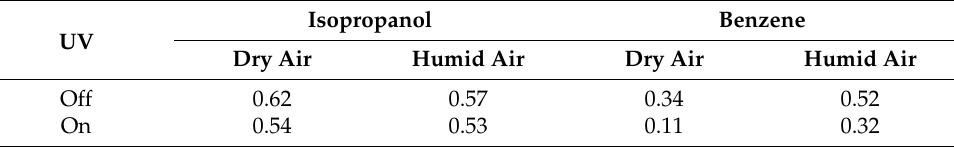
Table 1. The power index α of the S(C) curve for exemplary ZnO layer grown electrochemically for 550 s when exposed to isopropanol and benzene vapors at 150 ◦